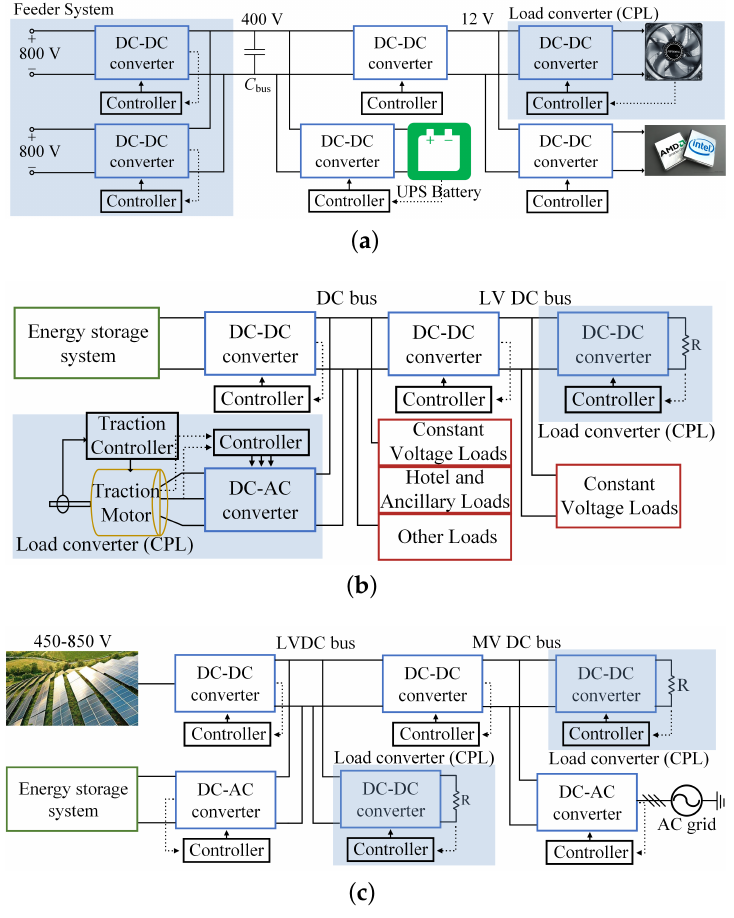
Figure 1. Some typical dual-stage cascaded dc systems [7,8]: ( a ) Data center dc power supply system. ( b ) Plug-in hybrid vehicle power supply system. ( c ) PV-storage integrated grid connected power supply system